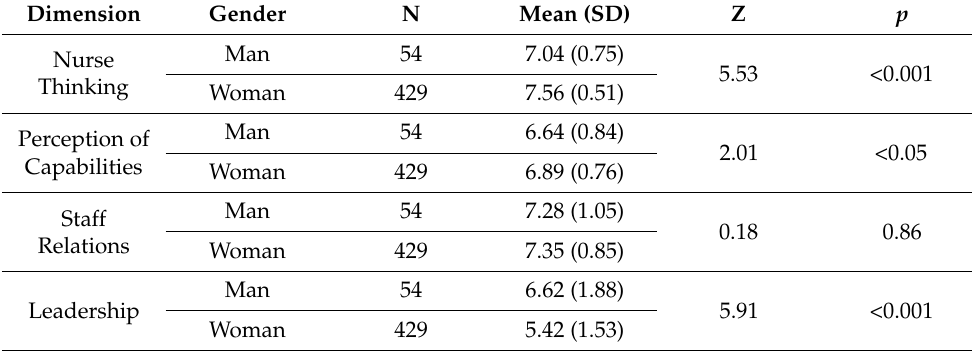
Table 4. Gender differences per group 1 .